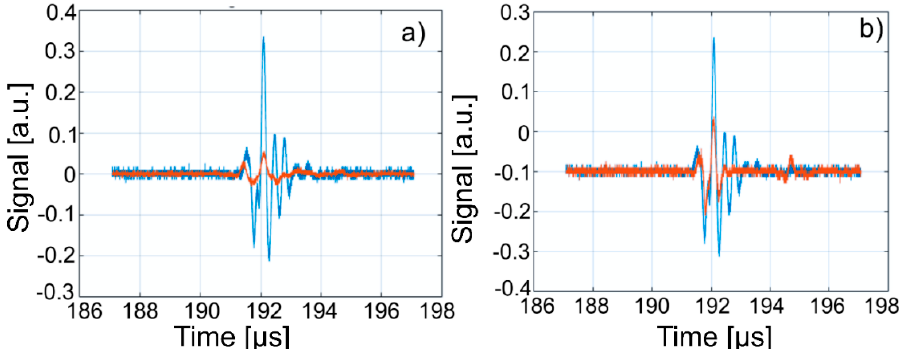
Figure 15. Overlapping of third echo of Wi (blue) over signals from: WZn ( a ); and Wd ( b ) (orange).